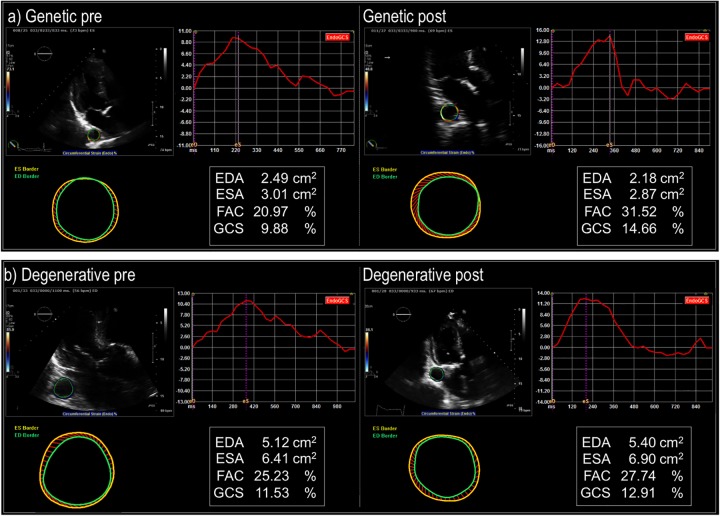
Representative examples of descending aortic strain assessed pre- and post- ascending aortic graft implantation in patients with congenital or genetically associated AA associated (top) and degenerative (bottom) AA.Circumferential strain over the entire cardiac cycle is represented by the red curve (upper right panel) from which systolic and diastolic frames were used to compute global circumferential strain (GCS); corresponding end-diastolic and end-systolic border delineation are represented by green and yellow circles (lower left). Note increased circumferential strain (Δ = 4.78) in a patient with congenitally associated aortic aneurysm (bicuspid aortic valve), despite similar pre-operative strain (Δ = 1.38) in a patient with a degenerative aortic aneurysm.